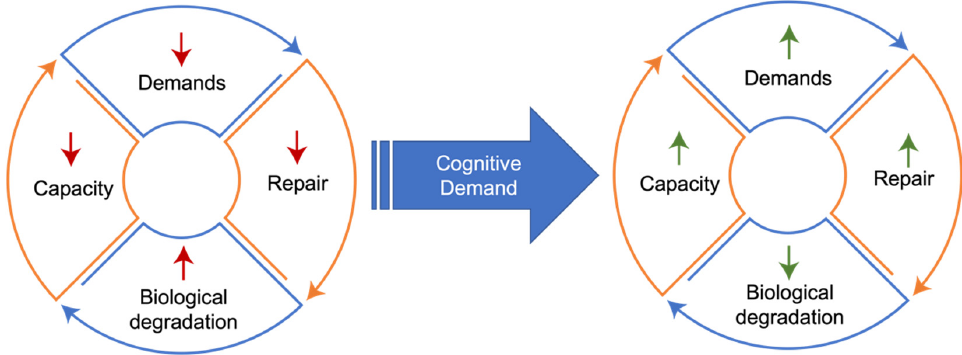
Figure 1. Demand-function coupling. Lack of cognitive demand drives a reduction in coupled reparative processes, ultimately resulting in less function and less capacity to initiate demand in a feed-forward process. Increased cognitive demand can reverse these processes, improving homeostasis and function.